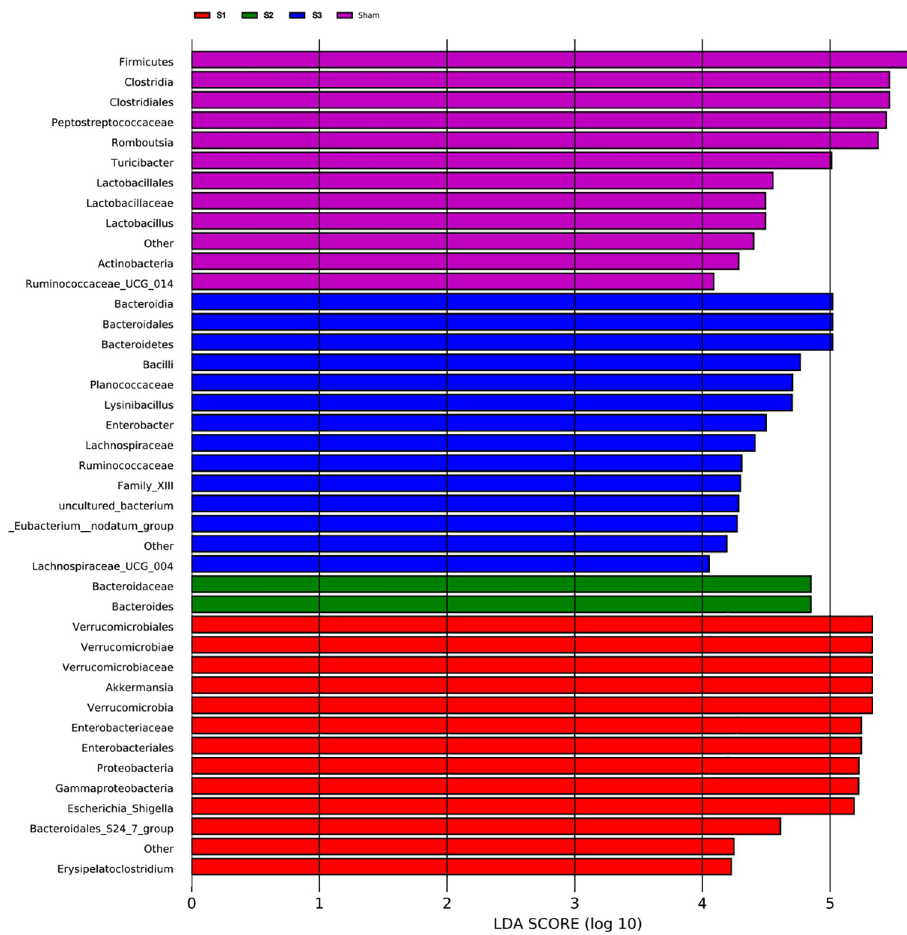
Fig 9. LEfSe analysis for identification of differentially abundant taxa in SBO compared to sham rats. The length of the horizontal bar represents the LDA score in log scale, and only taxa meeting an LDA score threshold > 4.0 are